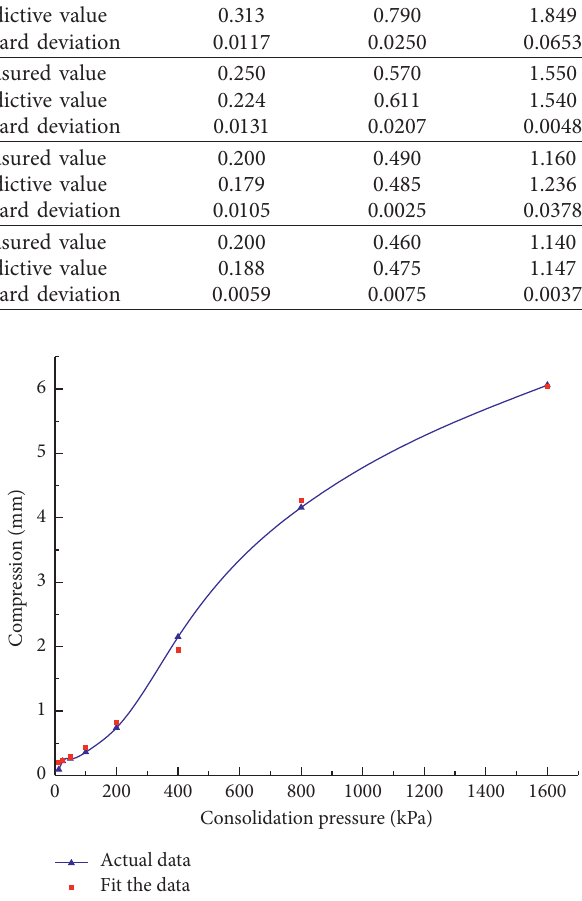
Figure 19: Fitting results with different consolidation pressure. Table 12: Value of different consolidation